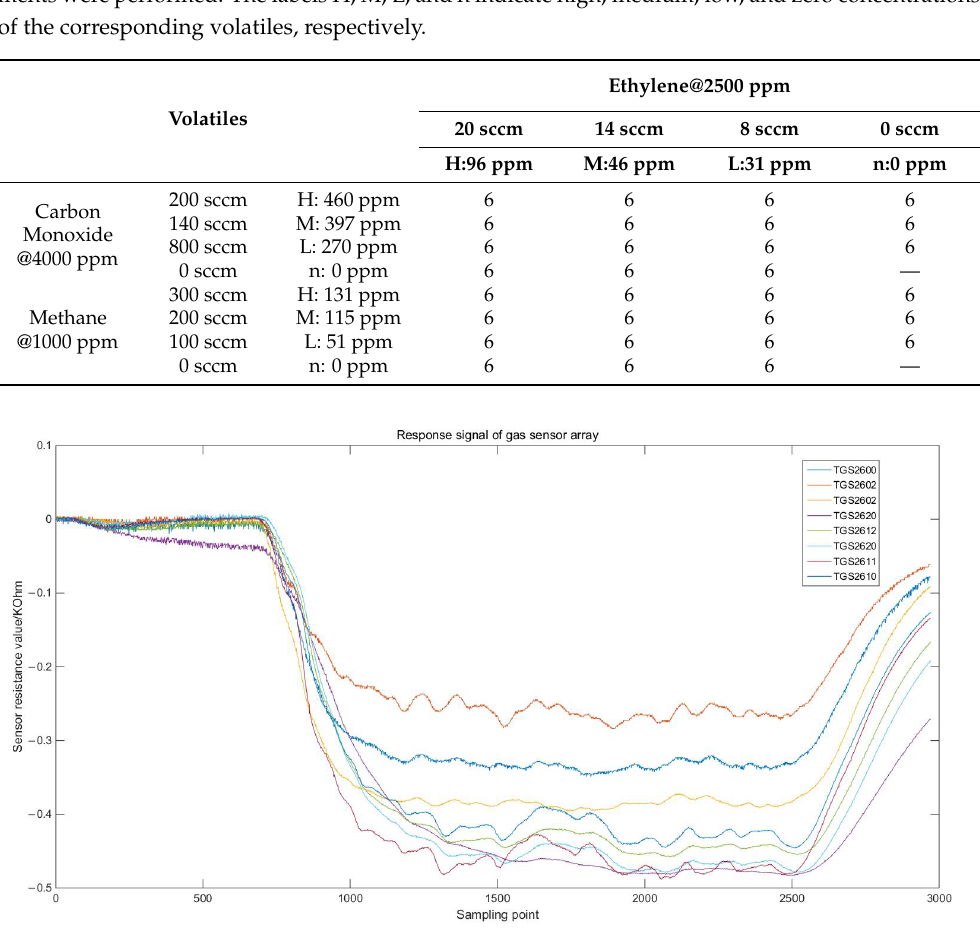
Figure 6. Response curves of ethylene and carbon monoxide gas mixtures.